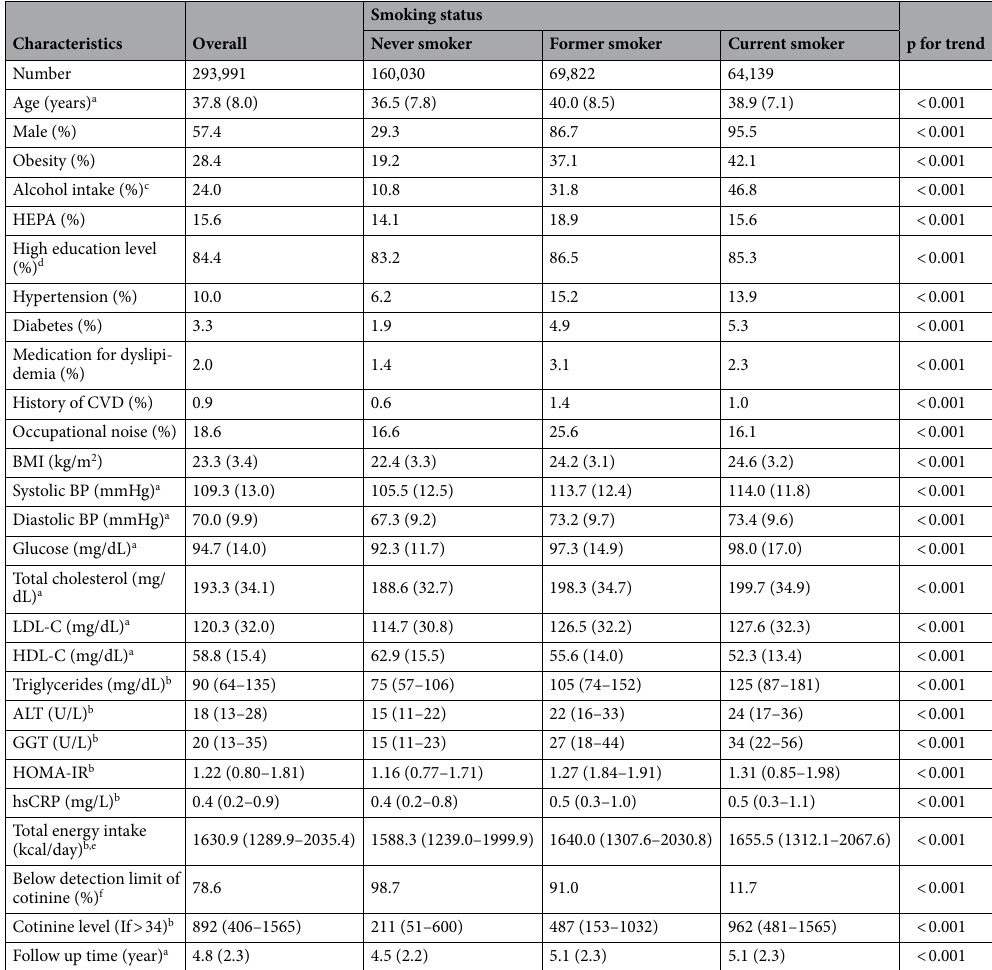
Table 1. Baseline characteristics of study participants by smoking status. Data are presented as a means (standard deviation), b median (interquartile range), or percentages. ALT alanine aminotransferase, BMI body mass index, BP blood pressure, GGT gamma glutamyl transferase, HDL-C high-density lipoprotein-cholesterol, HEPA health-enhancing physically active, HOMA-IR homeostasis model assessment of insulin resistance, hsCRP high sensitivity C-reactive protein, LDL-C low-density lipoprotein-cholesterol. c Alcohol intake ≥ 20 g of ethanol per day. d ≥ College graduate. e Among 208,266 subjects with plausible estimated energy intake levels (within three standard deviations from the log-transformed mean energy intake). f Cotinine level ≤ 34 among 207,893 subjects with available cotinine